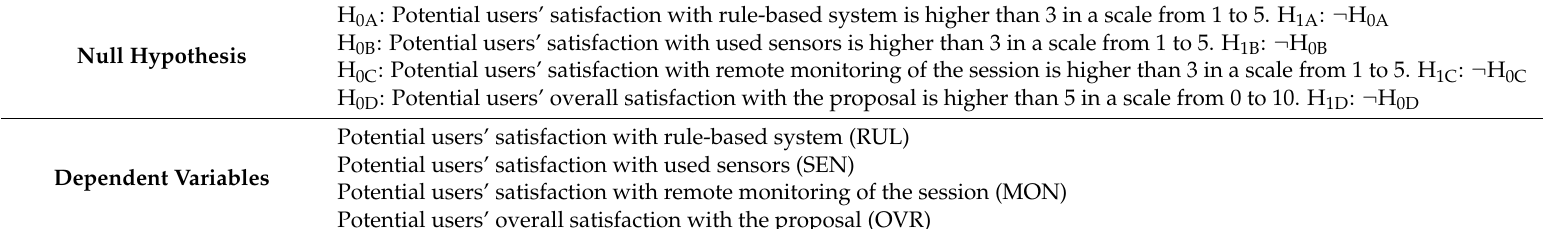
Table 3. Main features of the experiment.